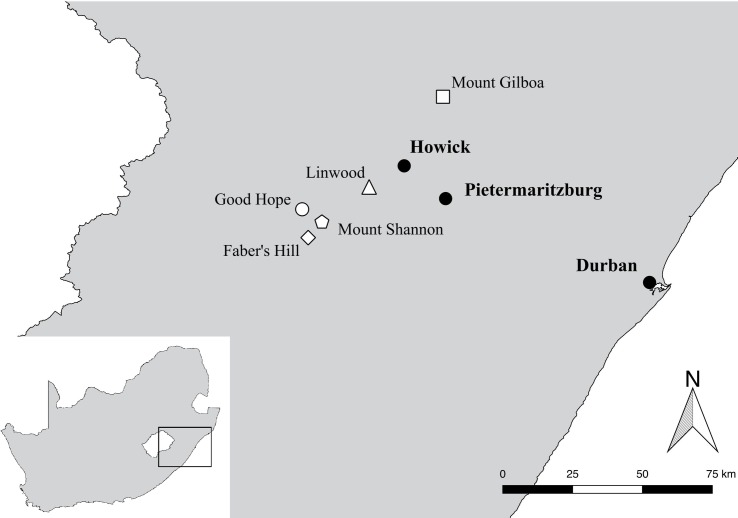
Locations of sampling areas in the Maputaland-Pondoland-Albany biodiversity hotspot.Pentagon: Mount Shannon Estate, diamond: Faber’s Hill Estate, circle: Good Hope Estate, triangle: Linwood Estate, and square: Mount Gilboa Estate. Black circles represent nearby towns.